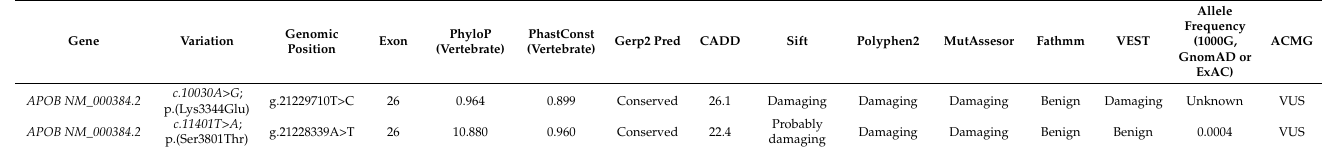
Table 2. In silico analysis of conservation and pathogenicity of the APOB variants characterized.